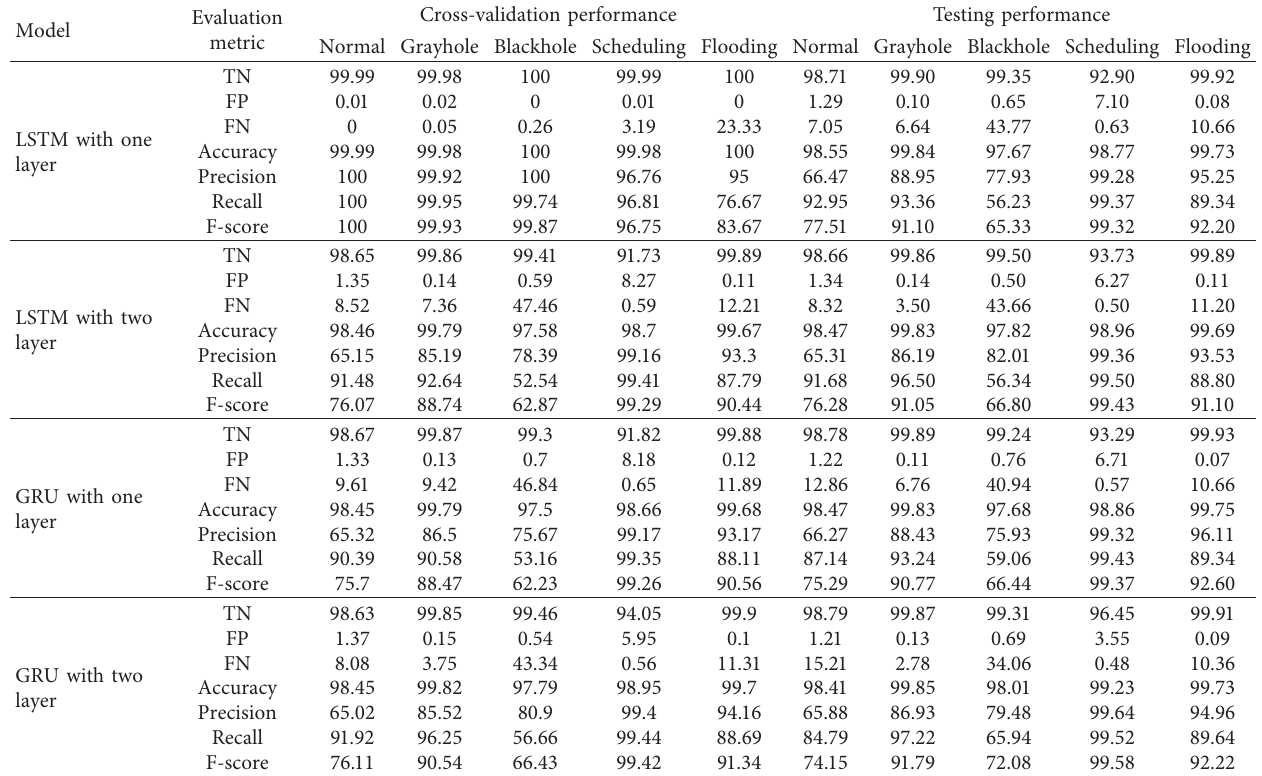
Table 12: The performance of deep learning for WSN dataset using LSTM and GRU with all features. Evaluation Model